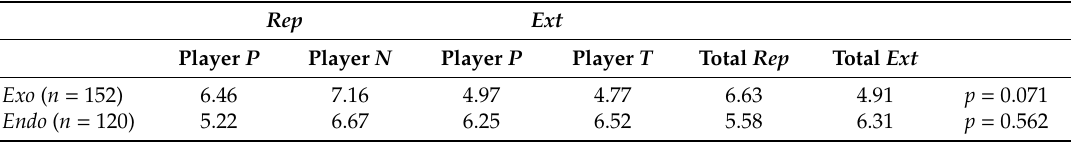
Table 7. Mean contribution in part